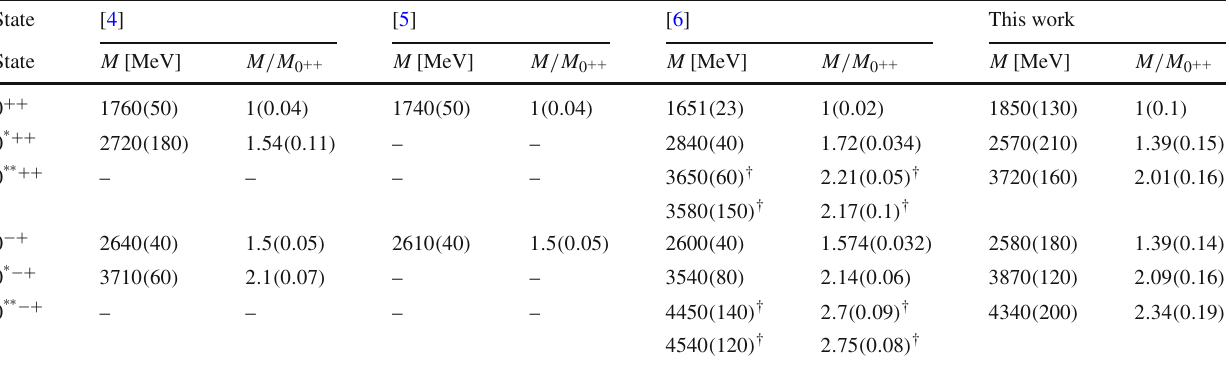
our results, the error comes from the extrapolation method. All results use the same value for r 0 = 1 /( 418 ( 5 ) MeV ) , see text for details. The related error is not included in the table. Masses with † are